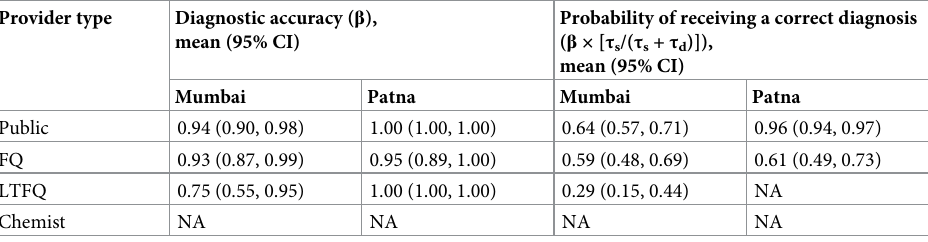
Table 7. Diagnostic accuracy and probability of receiving a correct